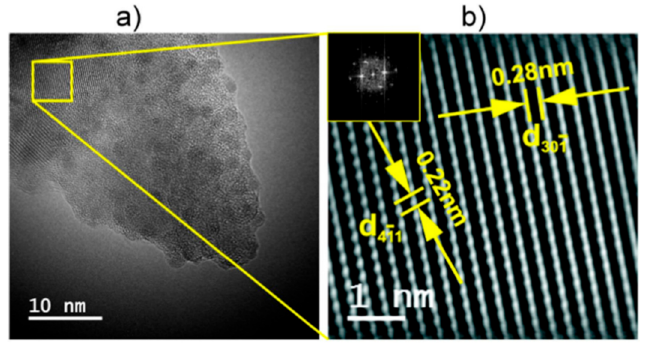
Figure 8. Microstructure of different fragments of glassy sample LiFe 0.80 V 0.08 PO 4 (denoted as G08) nanocrystallized at 480 ◦ C: ( a ) STEM image of nanograins closely packed in a glassy matrix and ( b ) a magnified HR-TEM image of an interface between a nanograin and a glassy phase [Reproduced with permission from ref. [45]. Copyright 2015, Elsevier.].